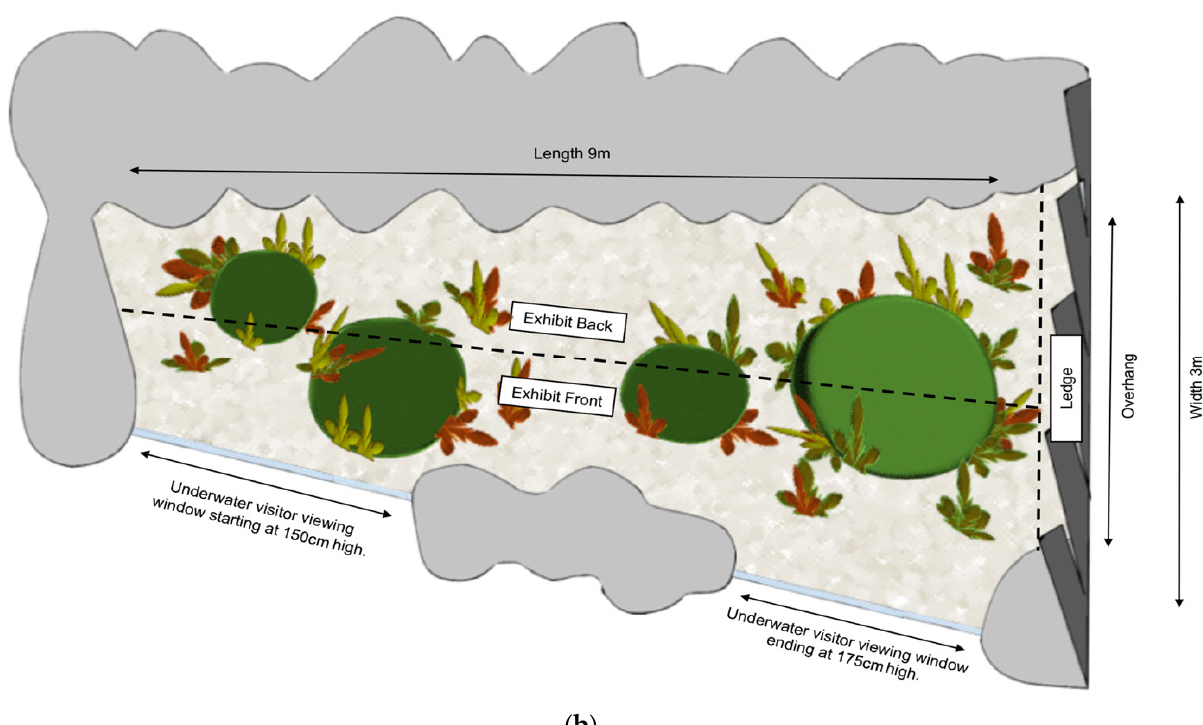
Figure 1. ( a ) The tank at Melbourne Zoo where all species were housed prior to renovations. Dark grey shapes represent large rocky structures (without shelter), two PVC pipes for shelter are represented by white cylinders. ( b ) The tank at Melbourne Zoo where all species were housed post renovations. Dark green and light green shapes represent rocky structures that are textured and provide multiple places for shelter, Multi-colour shapes represent the mock seaweed installed in the exhibit that provides complexity and shelter. The background colour change represents a change in substrate from thick shell grit to fine coral sand. For both ( a , b ) light grey areas around the outside of the tank represent mock rock and light blue lines indicate where visitor viewing was possible through glass. Locations for behavioural sampling are indicated by dotted lines and